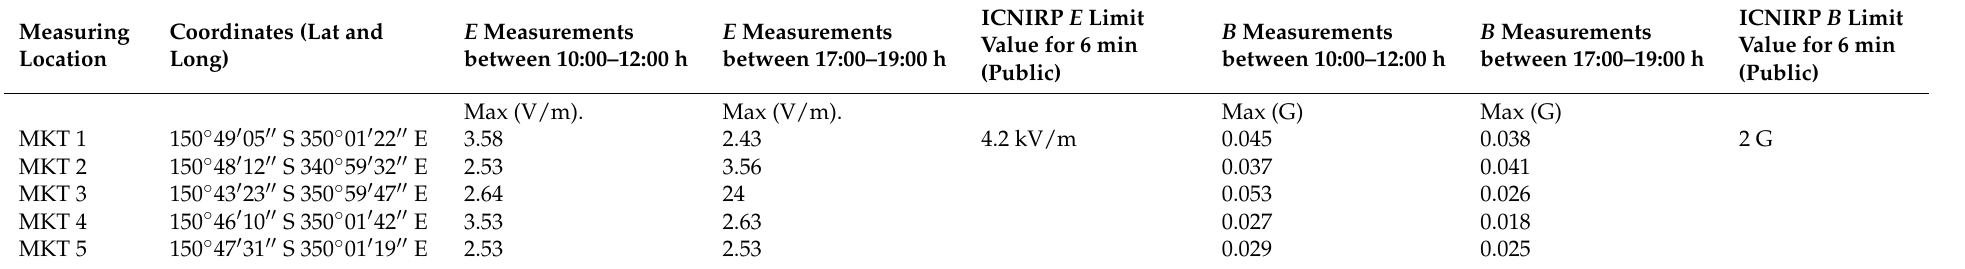
Table 7. Statistical results of E and B in markets.